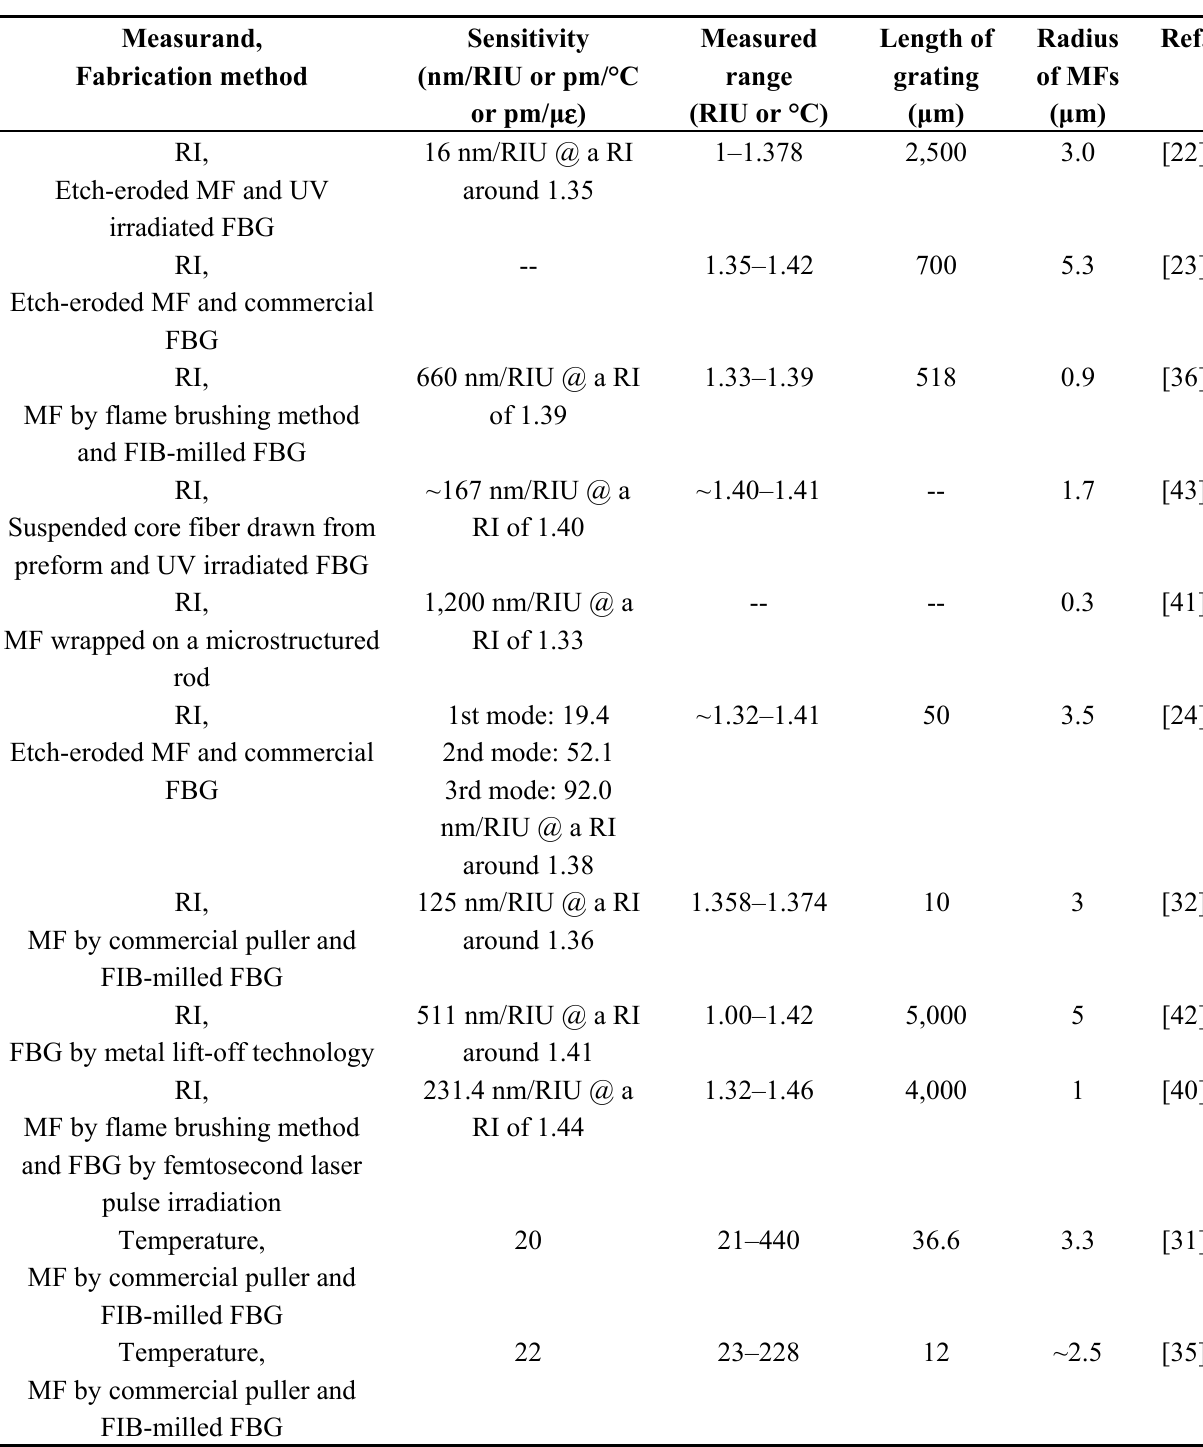
Table 1. A summary of MFBG sensors reported in the